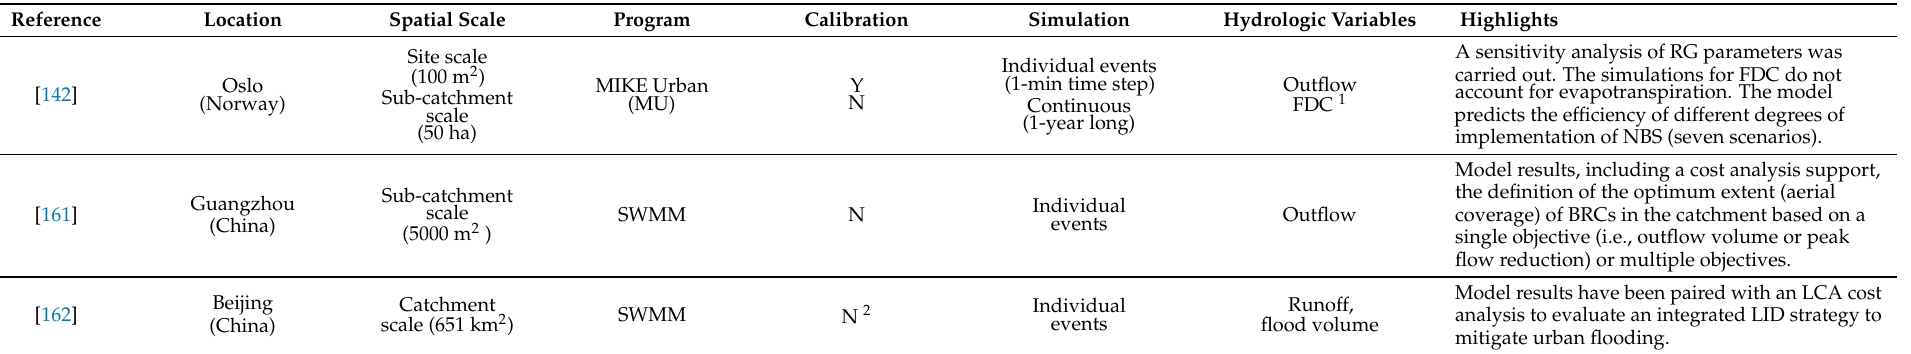
Table 6. Modeling studies of the hydrologic processes in BRCs on the subcatchment scale, eventually including model calibration at the site scale for a single BRC installation. For each study, the site characteristics, including the location and spatial scale, are reported together with the modeling features, including the calibration phase, simulation conditions, and modeled